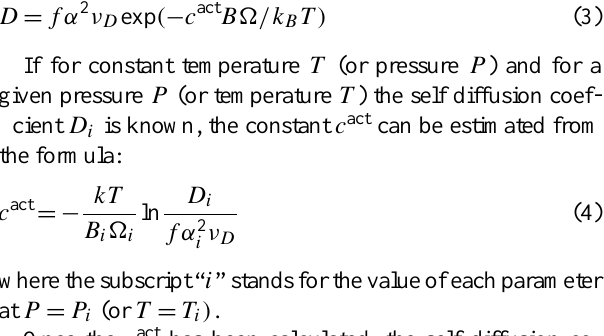
Fig. 1. Pressure dependence of the self diffusion coefficient of O in MgO for T = 2000K. Triangles denote the experimental data and Fig.1 solid circles the calculated